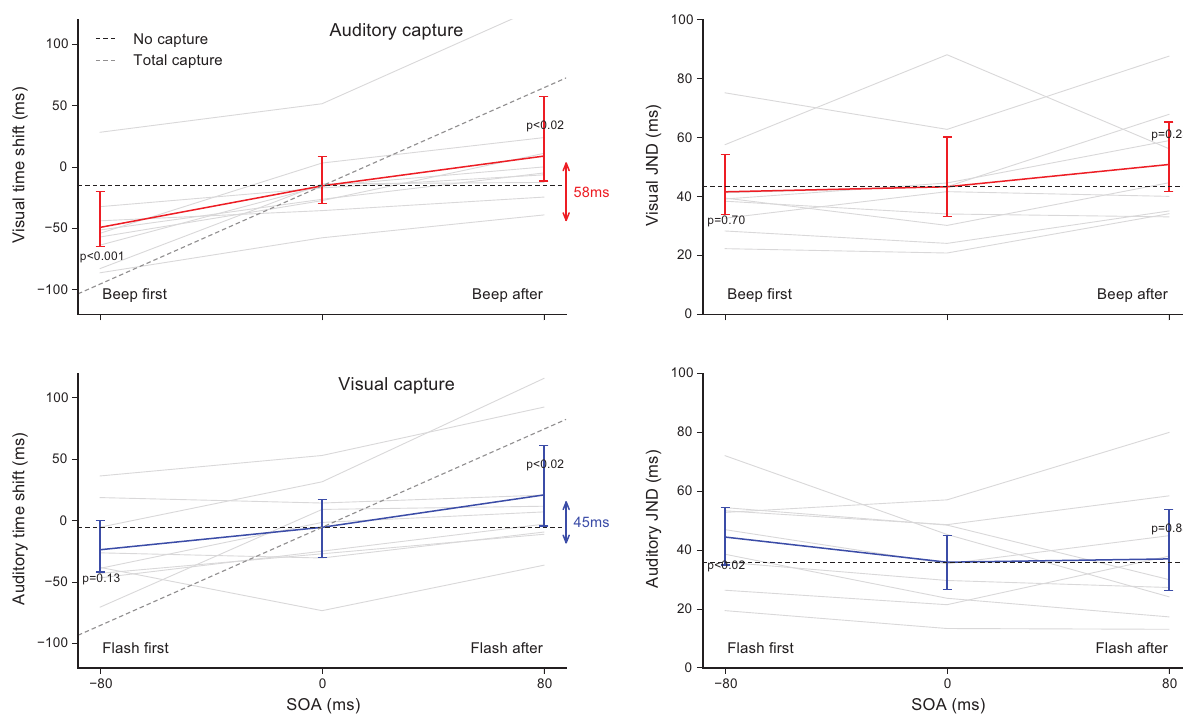
Fig 6. Results of Experiment 4. Time shifts produced by auditoryand visual capture accordingto the SOA (left plots) and the correspondingvisual and auditory JNDs (right plots) . The red and blue lines show the averages across participants(gray lines: individual results, error bars: 95% confidence intervals). Black and gray dashedlines show the predictions for absenceof capture (SOA = 0ms baseline)and total capture. For each condition, p-valuesindicate how significantis the difference with the SOA = 0ms condition(paired Student’s t-tests with α set at 0.025 using Bonferroni correction for multiple